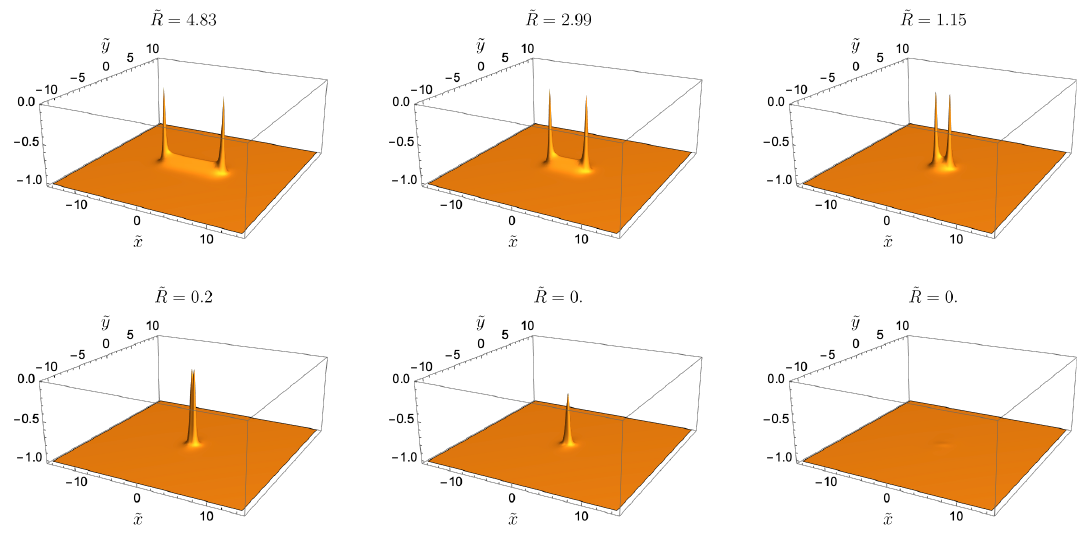
Figure 2 . The soliton attached by a vortex and anti-vortex in 2 + 1 dimensions. The negative amplitude ( −| ˜ φ | ) is